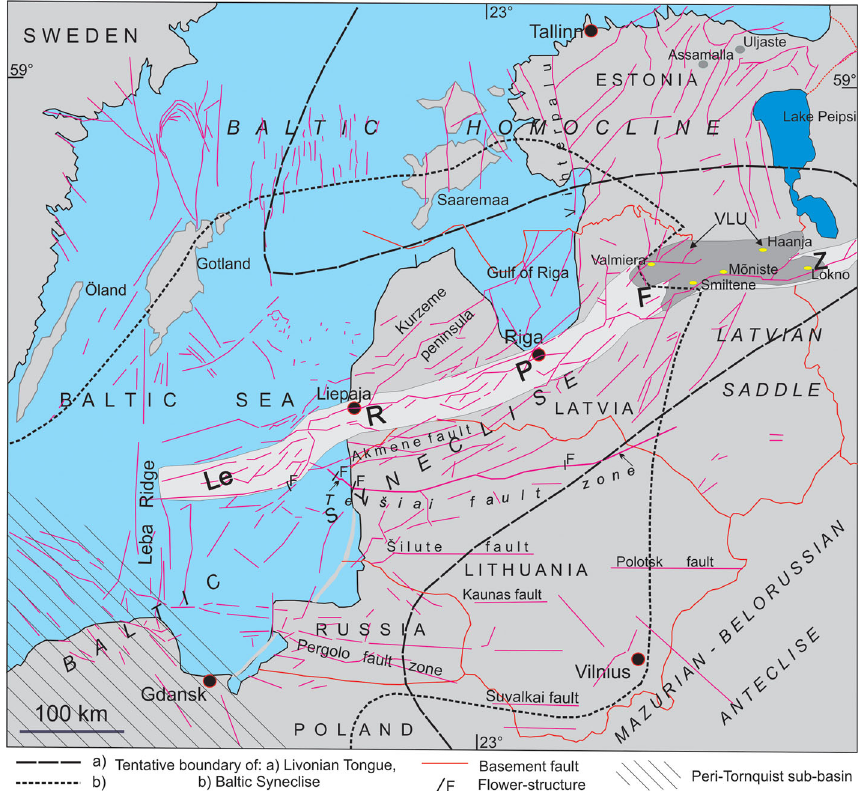
Fig. 3. Map of basement faults with dislocated platform cover in the NW East European Craton (after Flodén 1980; Puura & Vaher 1997; Tuuling & Flodén 2001; Brangulis & Kanev 2002; Sliaupa & Baliukevicius 2011; Šliaupa & Hoth 2011) with locations of the Leba Ridge, Leba Ridge–Riga–Pskov Fault Zone (LeRPFZ) and the Valmiera–Lokno Uplift (VLU) with five basement-cored